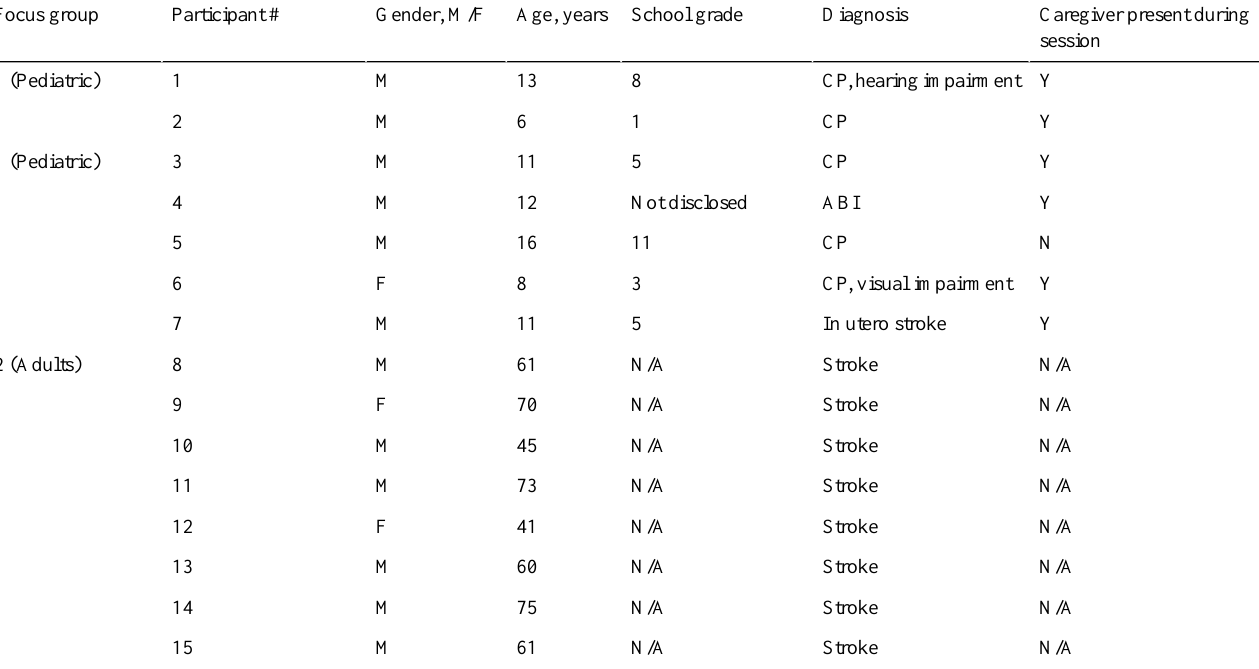
Table 1. Participant demographic